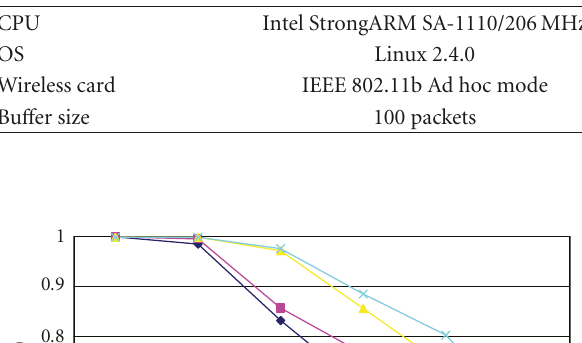
Table 1: Specifications of IN A/IN B.